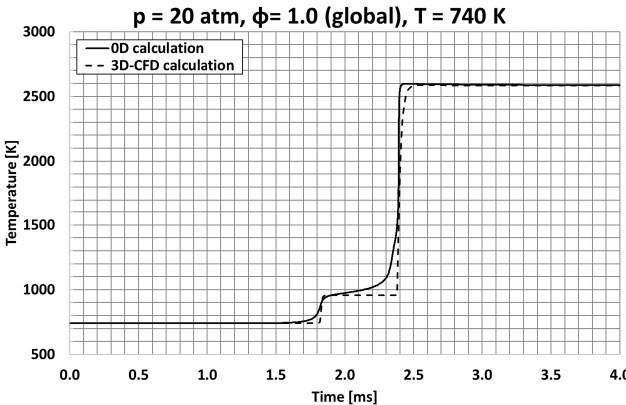
Figure 9. Comparison of 0D calculation with 3D-CFD calculation with tabulated values.